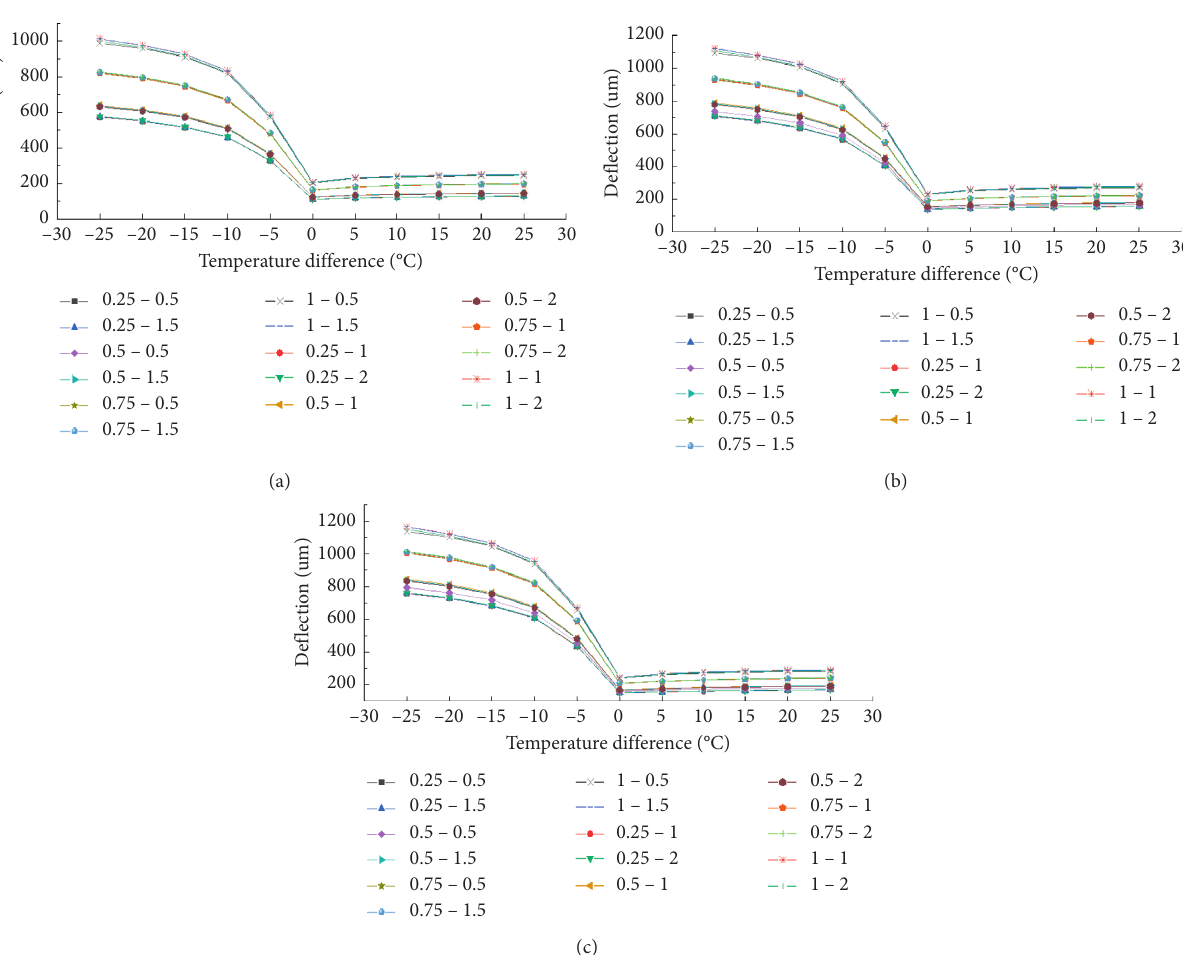
Figure 5: Deflection at plate angle load center point under plate edge void conditions. (a) 50kN. (b) 70 kN. (c)